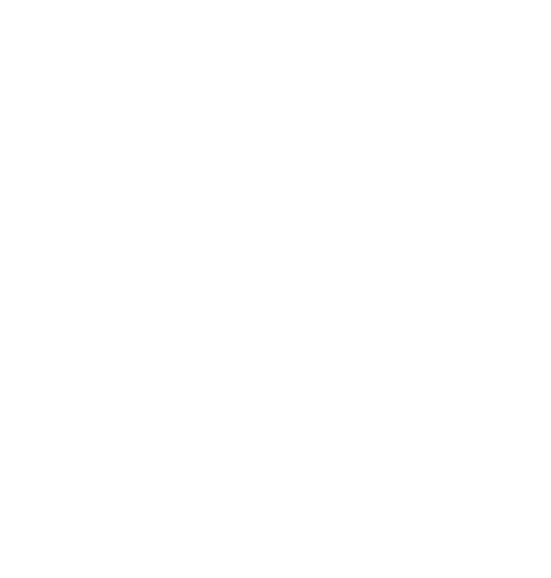
Table 1. Parameters obtained from porosity